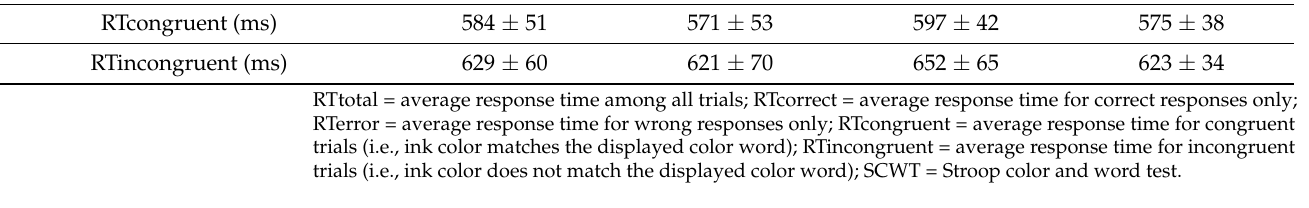
Table 1. Descriptive statistics (means ± standard deviations) of SCWT response times.